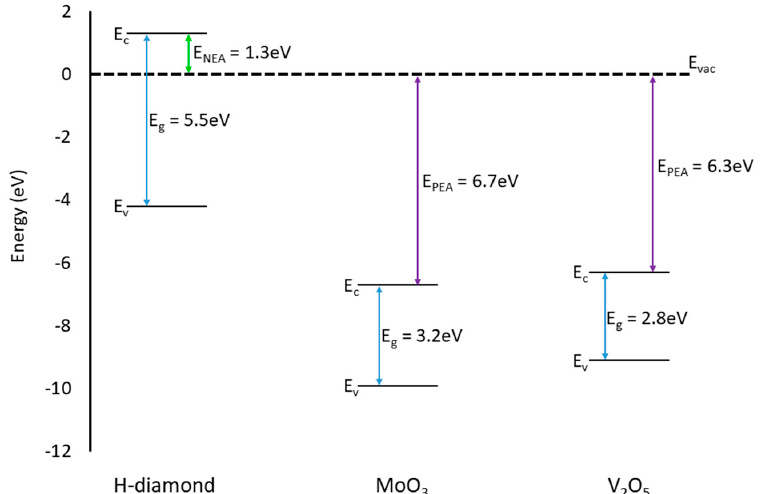
Figure 12. Energy band diagram showing the VBM and CBM positions for H-diamond (left hand side), MoO 3 (middle), and V 2 O 5 (right hand side) [30,40,41].